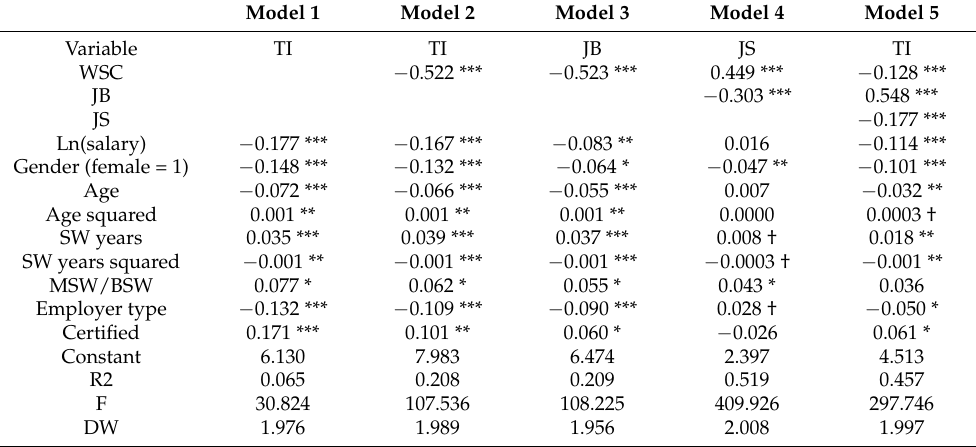
Table 3. Regression